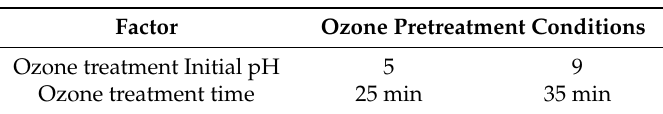
Table 2. Level of Ozone Pretreatment